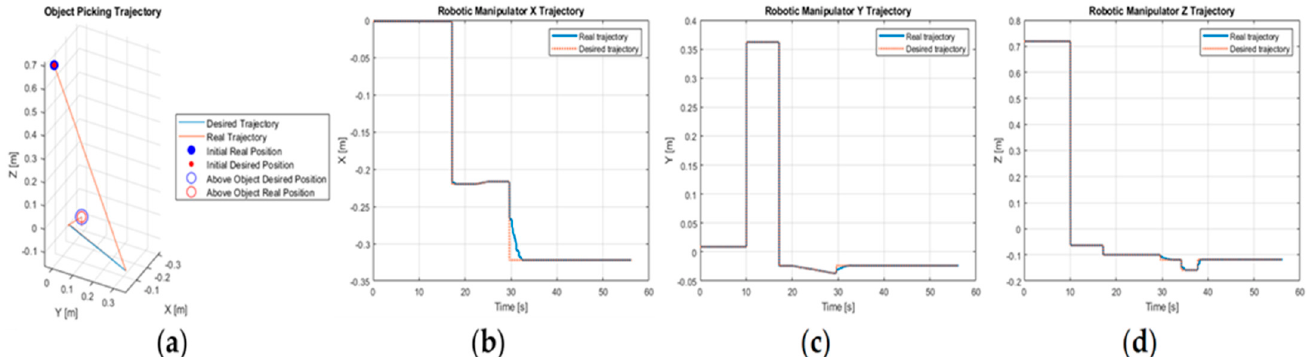
Figure 25. Desired and real object picking trajectories of the RM Cyton based on inverse kinematics control and eye-in-hand VSS for accurate positioning at the FC: ( a ) the complete trajectory, from the home position to above object position, ( b ) X axis, ( c ) Y axis, ( d ) Z axis trajectories.